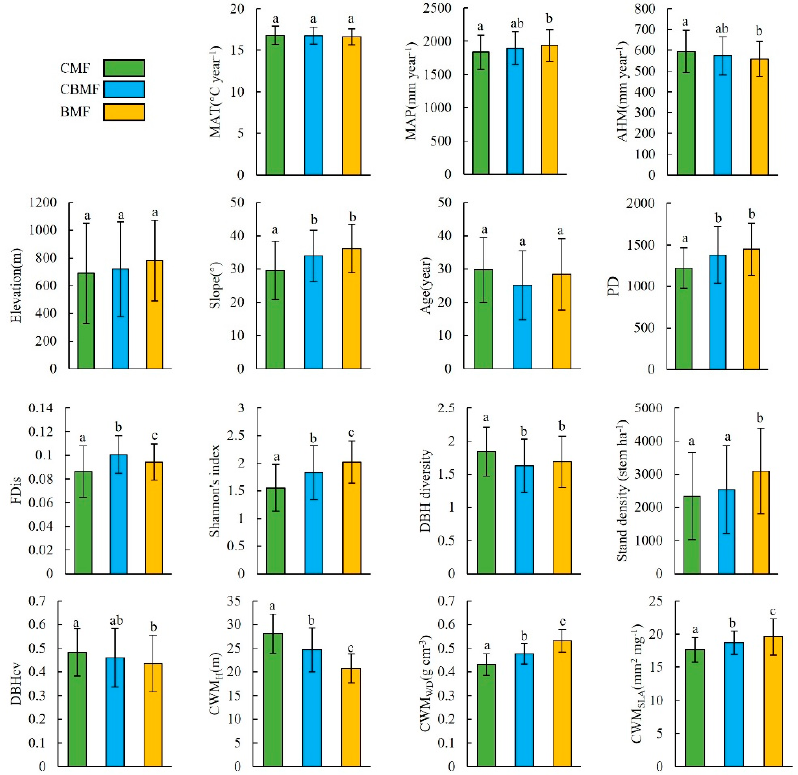
Figure 4. One-way analysis of variance (ANOVA) and LSD tests were used to analyze the differences between the variables in the three different types of mixed forests. CMF, CBMF, and BMF represent mixed coniferous, mixed conifer-broadleaf, and mixed broadleaf forests, respectively.